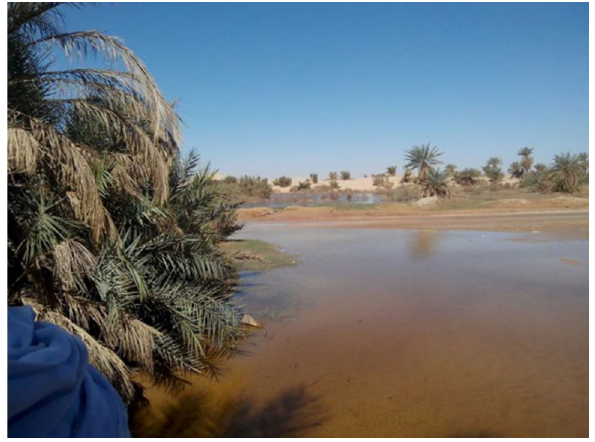
Fig. 21 Flooding of the Guemma palm grove. (photo. Authors 2018)